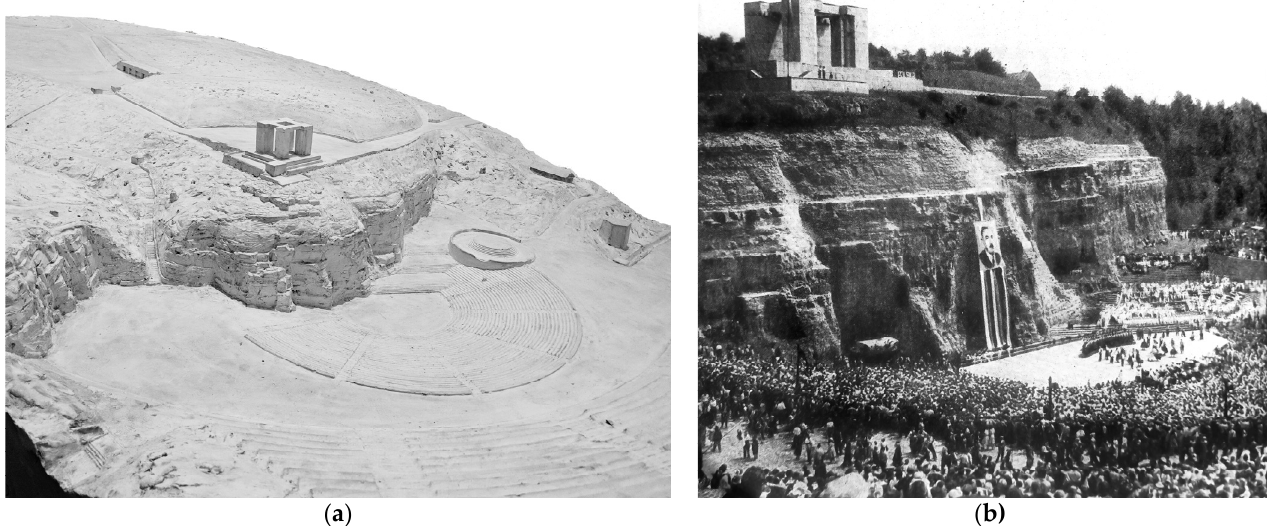
Figure 7. Saint Anne Mountain, the Monument of the Insurgents’ Deed, ( a ) development of area, model (National Museum in Warsaw, MKr 116 MNW, photo created by authors), ( b ) the monument unveiling ceremony, on the rock—a portrait of Boles ł aw Bierut (Pomnik Czynu, 70, photo Stefan Arczy ń ski).